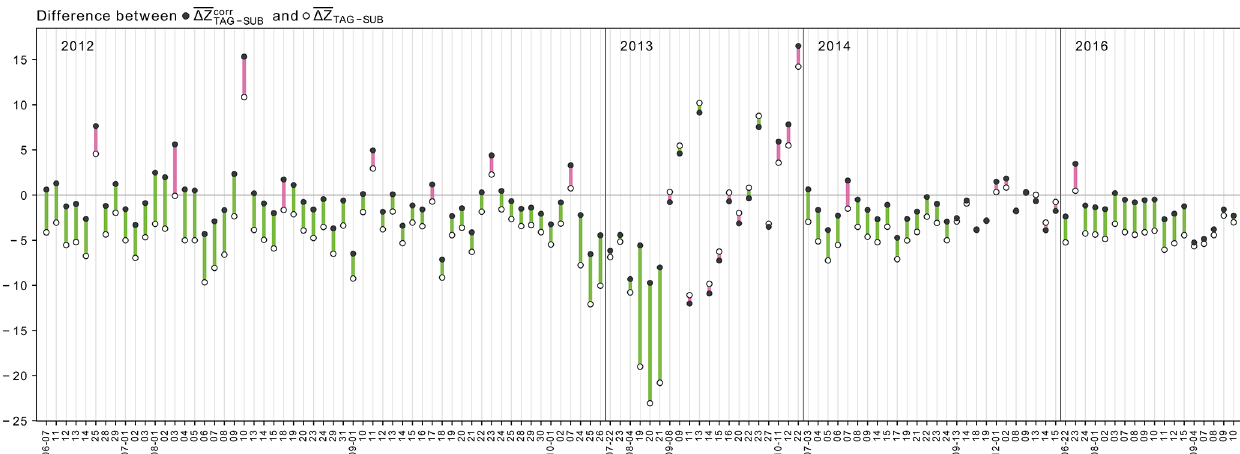
Figure 7. The differences between the inter-radar consistency before and after correcting for the ground radar calibration biases following a rolling window averaging for GR–GR pairs with more than 100 matches. The hollow (filled) circles represent the daily mean before (after) correction. The line color represents an improvement (green) or a decline (pink) in the consistency between the two ground